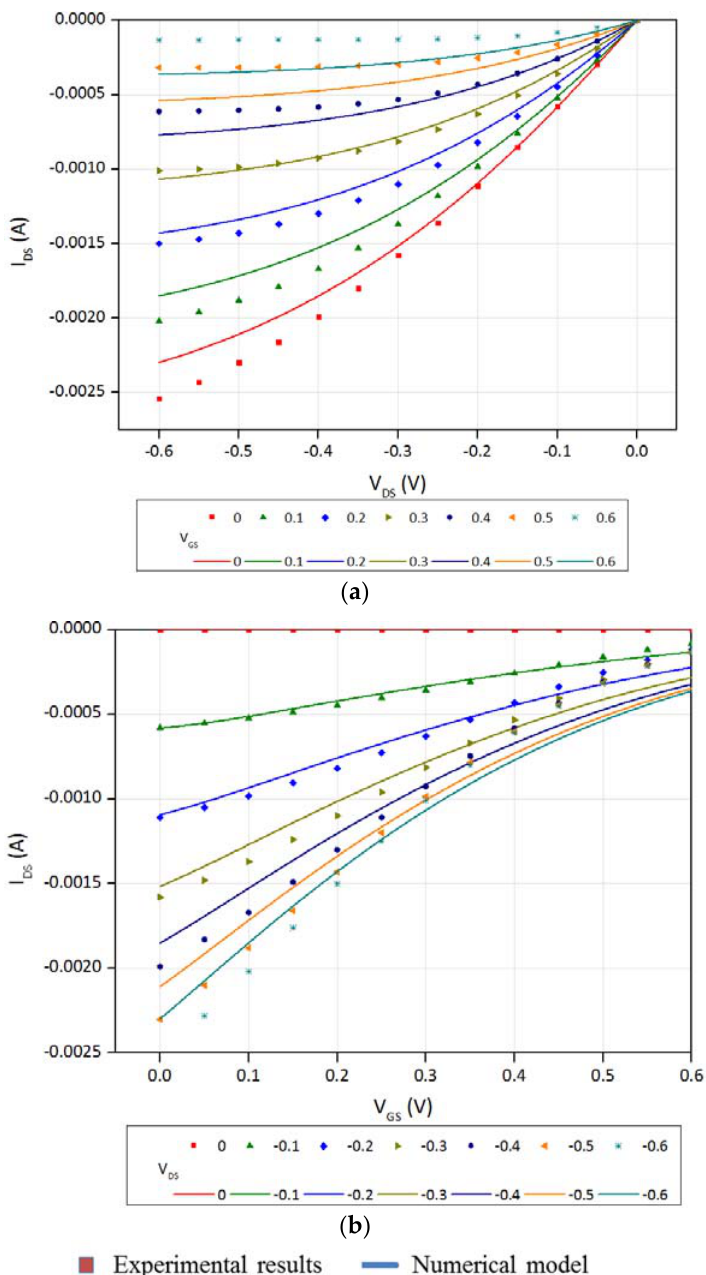
Figure 7. Calculated output ( a ) and transfer ( b ) curves of an OECT. The parameters used for the calculation are gathered in Table 1.